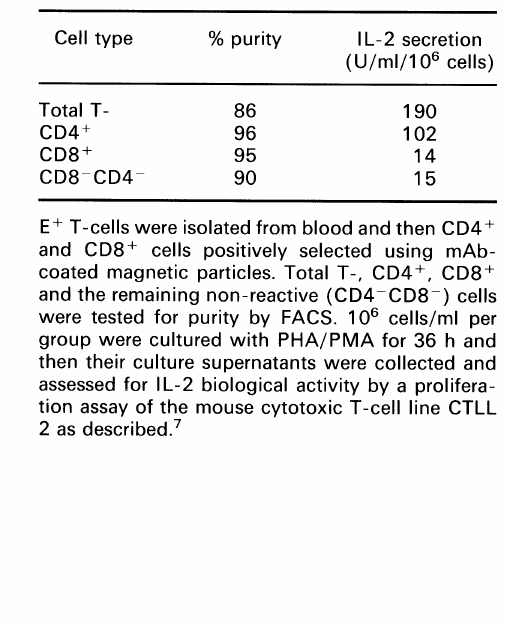
Table 1. IL-2 secretion from mitogen-induced peripheral blood T-cell